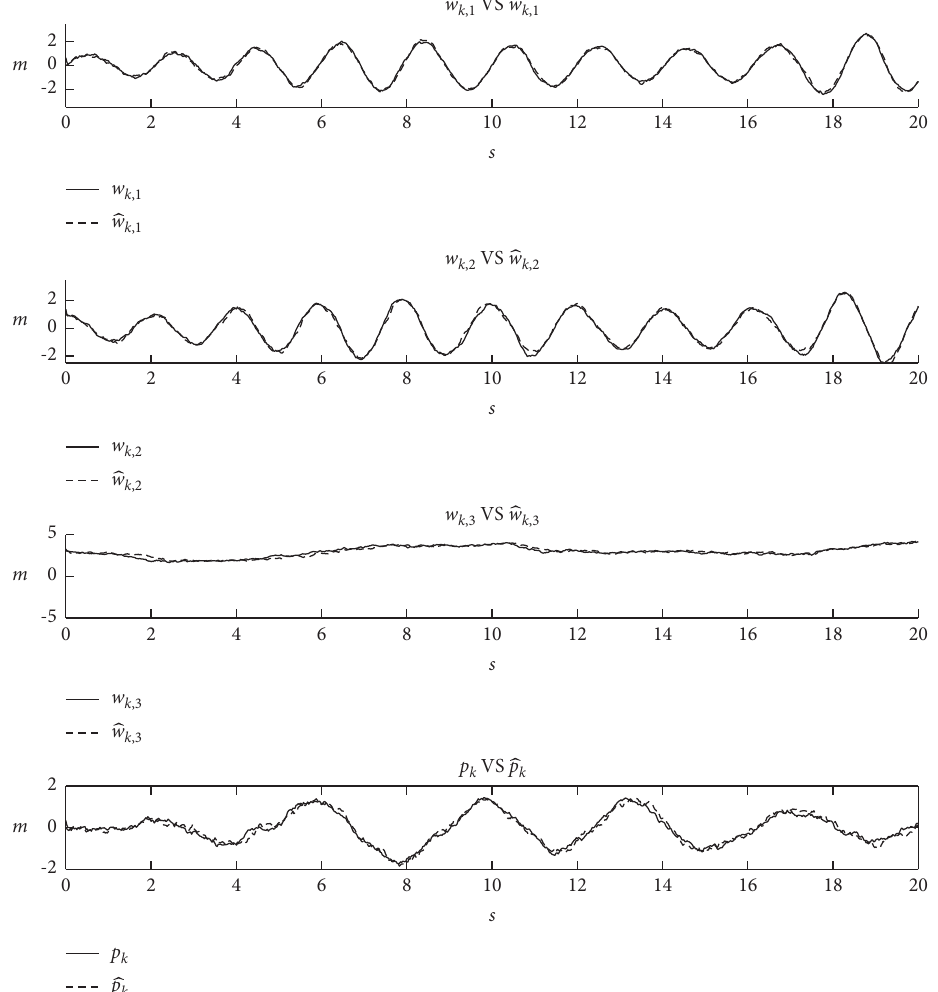
Figure 12: Estimation of random references and random